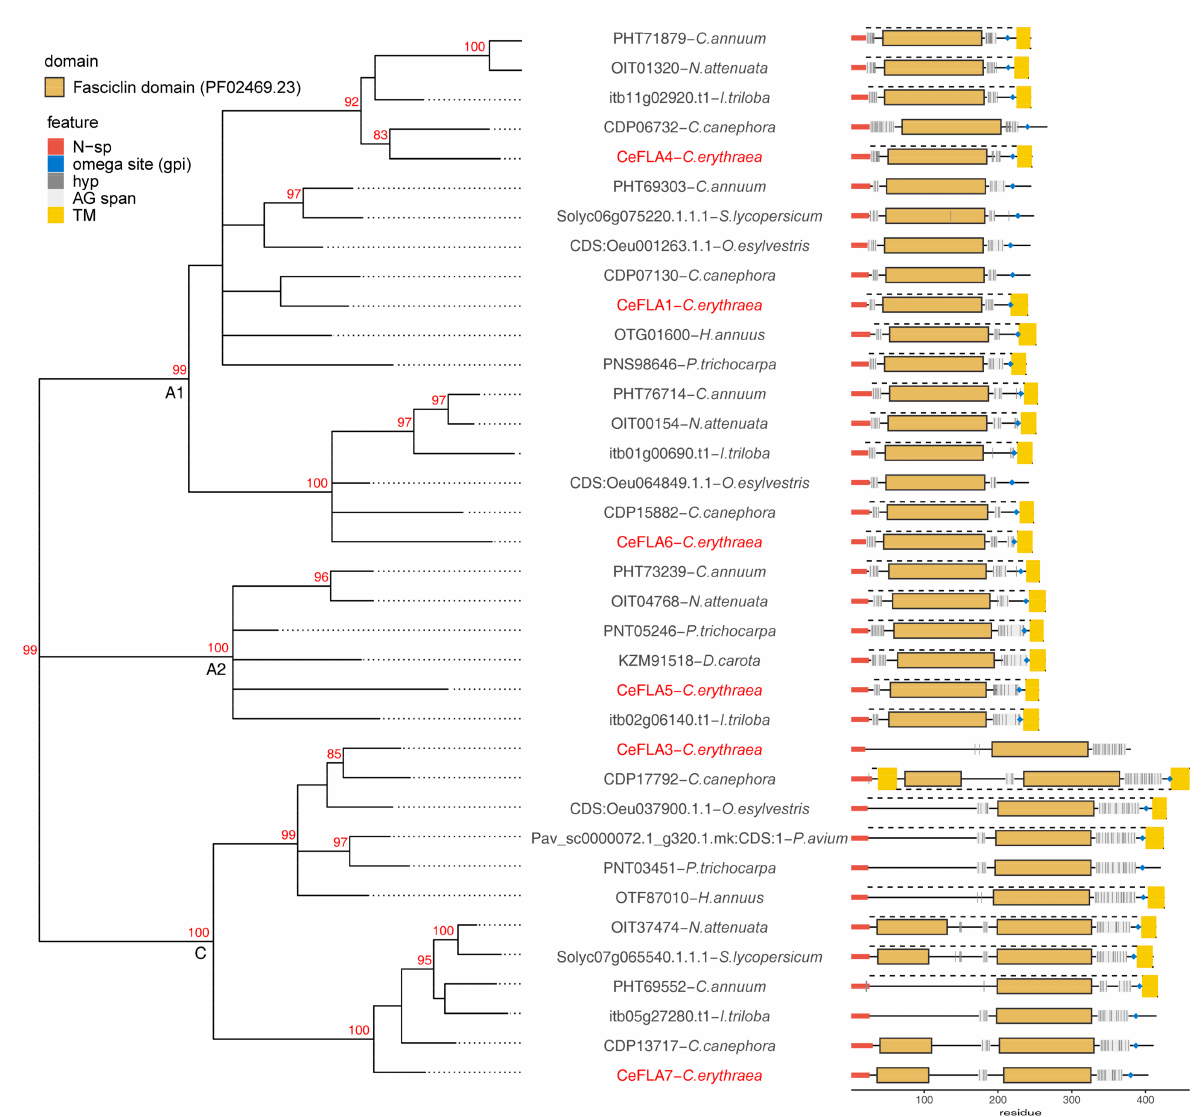
Figure 3. Phylogenetic relationship of six C. erythraea FLA protein sequences with homologues from other plant species. The phylogenetic tree represents an unrooted maximum likelihood tree constructed using the WAG amino acid model. Cluster stability was evaluated using 100 replicates of nonparametric bootstrap. Clusters with ≥ 80/100 bootstrap support are indicated with a red number. Clusters with ≤ 50/100 bootstrap support were collapsed into multichotomies. Protein schematic diagrams were constructed using ragp R package: N-sp as predicted by Signalp4.1 are represented with red segments on the N-terminus; GPI addition sites (omega sites) as predicted using NetGPI1.1 are represented with blue diamonds; domains as predicted with hmmscan 3.3.2 and using Pfam-A33 database are represented according to the color legend; transmembrane domains (TM) as predicted using Phobius1.01 are represented using yellow rectangles. Proteins with predicted TM extracellular regions are indicated with dashed lines above the sequence diagrams; hydroxyprolines, as predicted with ragp 0.32 are indicated with bar-code-like vertical black lines, while AG motif spans (at least three AG motifs, no more than 10 amino acids apart) are indicated with light grey rectangles. Clades are labeled according to